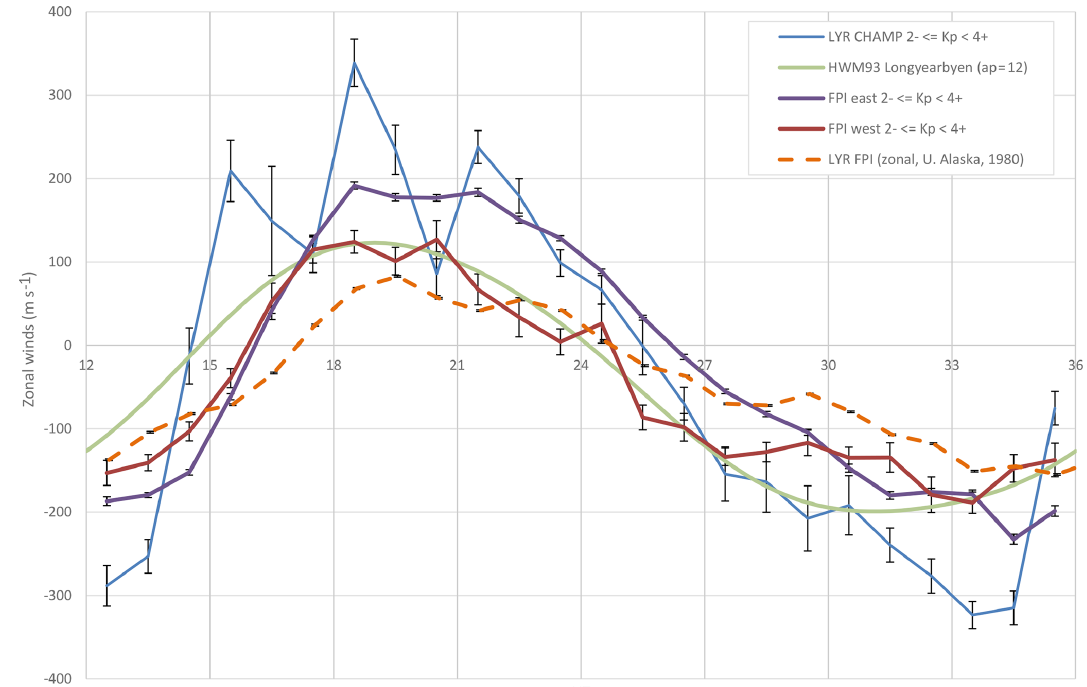
Figure 8. Longyearbyen (Svalbard) winters 2001–2003, 2 − ≤ Kp<4 + : average zonal winds measured using CHAMP and FPI, including standard errors of the mean. These are compared with FPI winds observed by the University of Alaska in 1980 and the HWM93 model